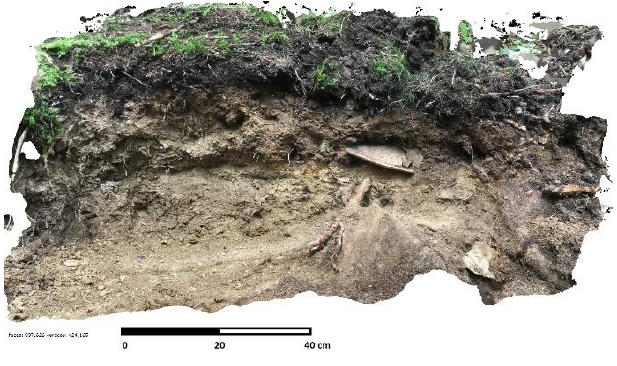
Figure 9. Looted archaeological dig, detail